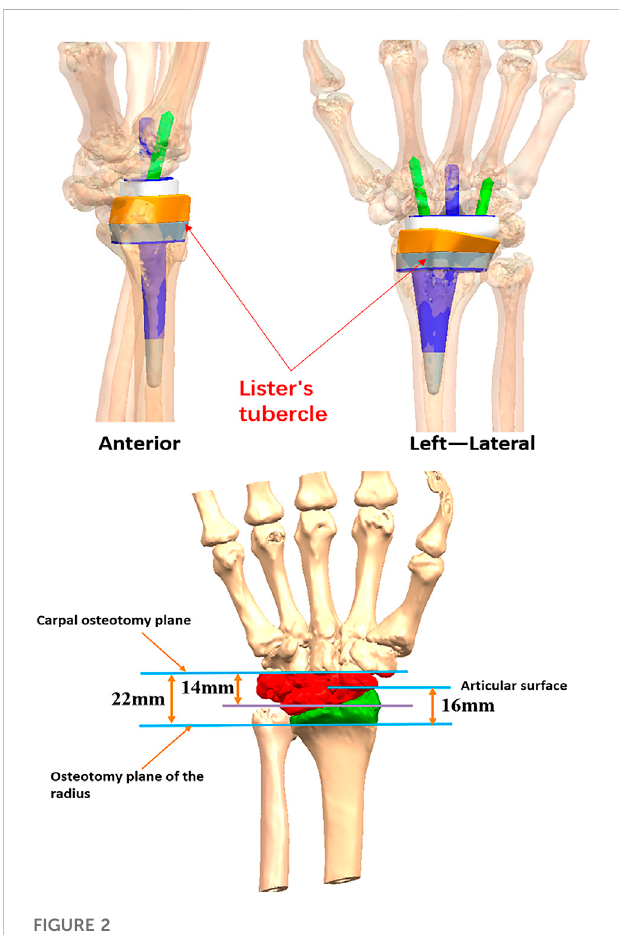
FIGURE 2 Preoperative wrist joint prosthesis design.